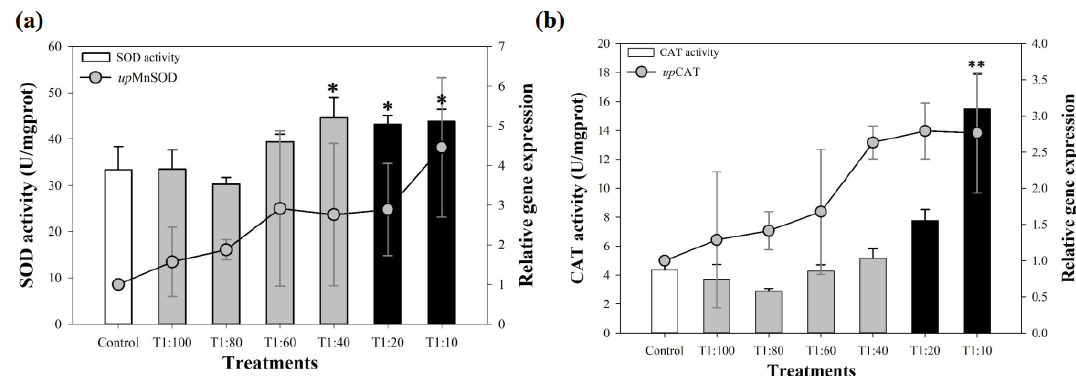
Figure 4. ( a ) Superoxide dismutase (SOD) activity and relative gene expression of manganese superoxide dismutase ( up MnSOD), and ( b ) catalase (CAT) activity and catalase gene expression ( up CAT) of Ulva prolifera under the exposure of di ff erent amounts of cell-free filtrate of Bacillus cereus BE23. T 1:100 , and T 1:80 ~T 1:10 indicate the treatments of volume ratio of cell-free filtrate of Bacillus cereus BE23 relative to f / 2 medium. Values are means ± SD (n = 3). * indicates a significant di ff erence ( p < 0.05) and ** indicates a significant di ff erence ( p < 0.001) compared to control.